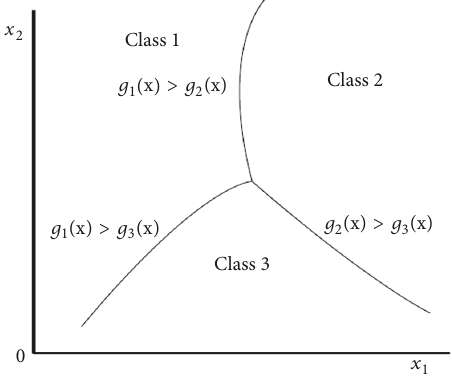
Figure 5: Class boundaries by all-at-once